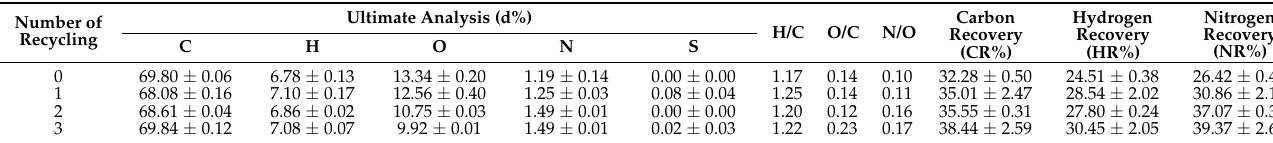
Table 7. Ultimate analysis of Bio-crude oil.